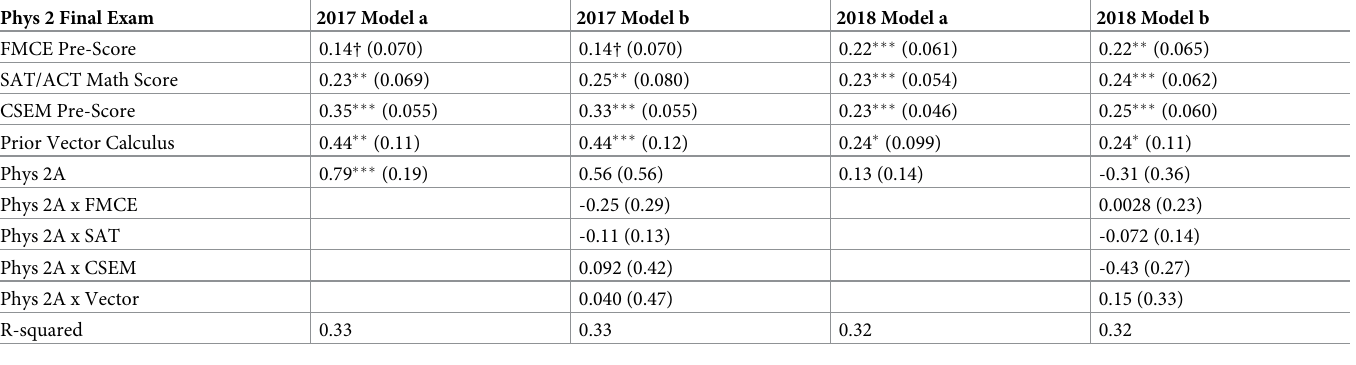
Table 3. Regression models for Phys 2 final exam performance as a function of incoming preparation and enrollment in Phys 2A. Coefficients are in units of stan- dard deviations and the numbers in parentheses are the standard errors. Phys 2 Final